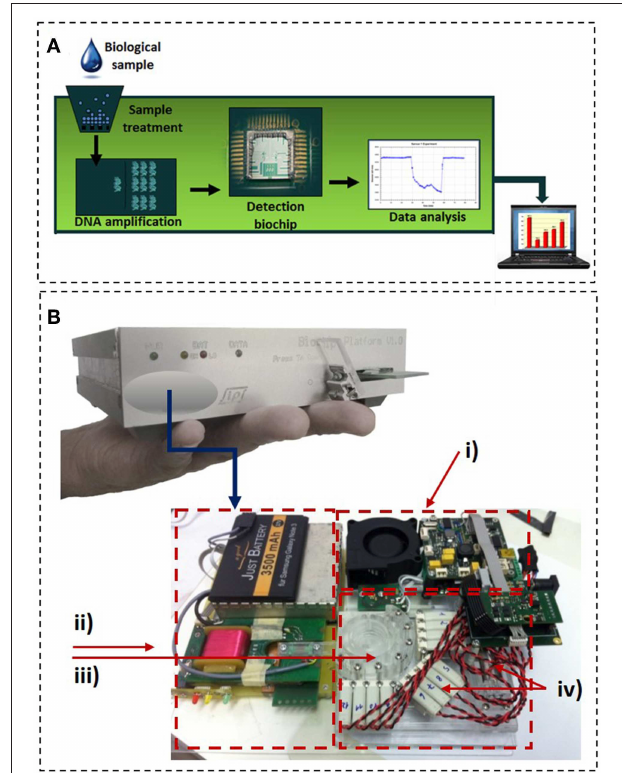
FIGURE 5 | Magnomics S.A. device. (A) Schematics of the concept proposed by Magnomics S.A. (B) Prototype device developed by Magnomics S.A. highlighting the microfluidic units for sample treatment, nucleic acid amplification, and detection: (i) Thermocycling; (ii) Magnetic detection; (iii) Sample preparation unit; (iv) Integrated valves and